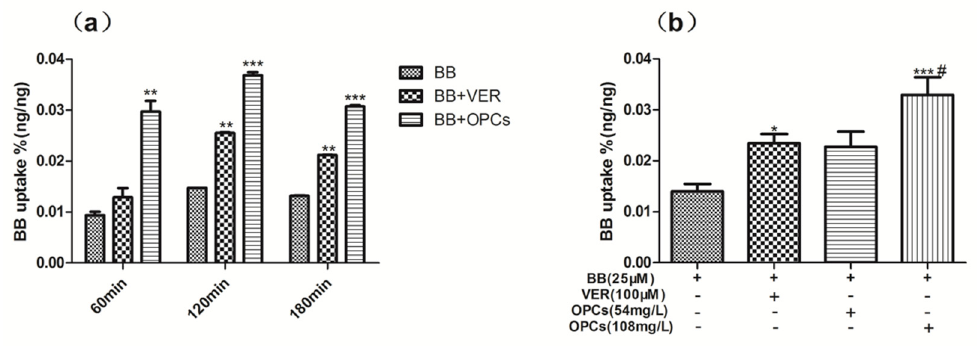
Figure 6. OPCs increased the uptake of BB in Caco-2 Cells. Caco-2 intestinal cells were treated with 25 µ M of BB and BB with OPCs at 108 mg/L for different time ( a ) or BB with OPCs at 54 mg/L or 108 mg/L for 2 h ( b ). Verapamil (100 µ M) was used as positive control, cells were harvested for determination of the uptake of BB. Quantities of BB in the cells were determined by LC–MS/MS. Data are presented as mean ± SEM of three independent experiments. * p < 0.05, ** p < 0.01, *** p < 0.001 vs. control (BB alone), # p < 0.05 108 mg/L of OPCs vs. verapamil.